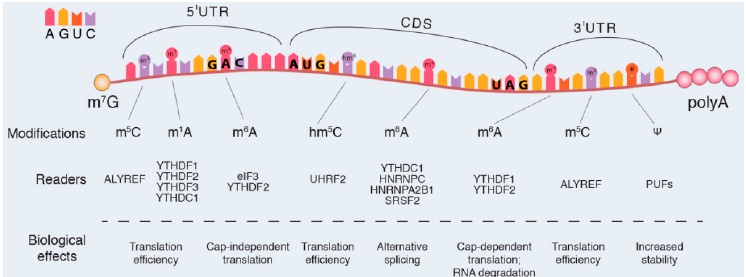
Figure 1. The figure illustrates the possible chemical modifications at the different messenger RNA (mRNA) nitrogen bases. The preferential location of each mark within the mRNA sequence and the reader proteins are also shown (see the text for details). N6-methyladenosine: m 6 A; Pseudouridine: Ψ ; 5-methylcytosine: m 5 C; 5-hydroxymethylcytidine: hm 5 C; N1-methyladenosine: m 1 A